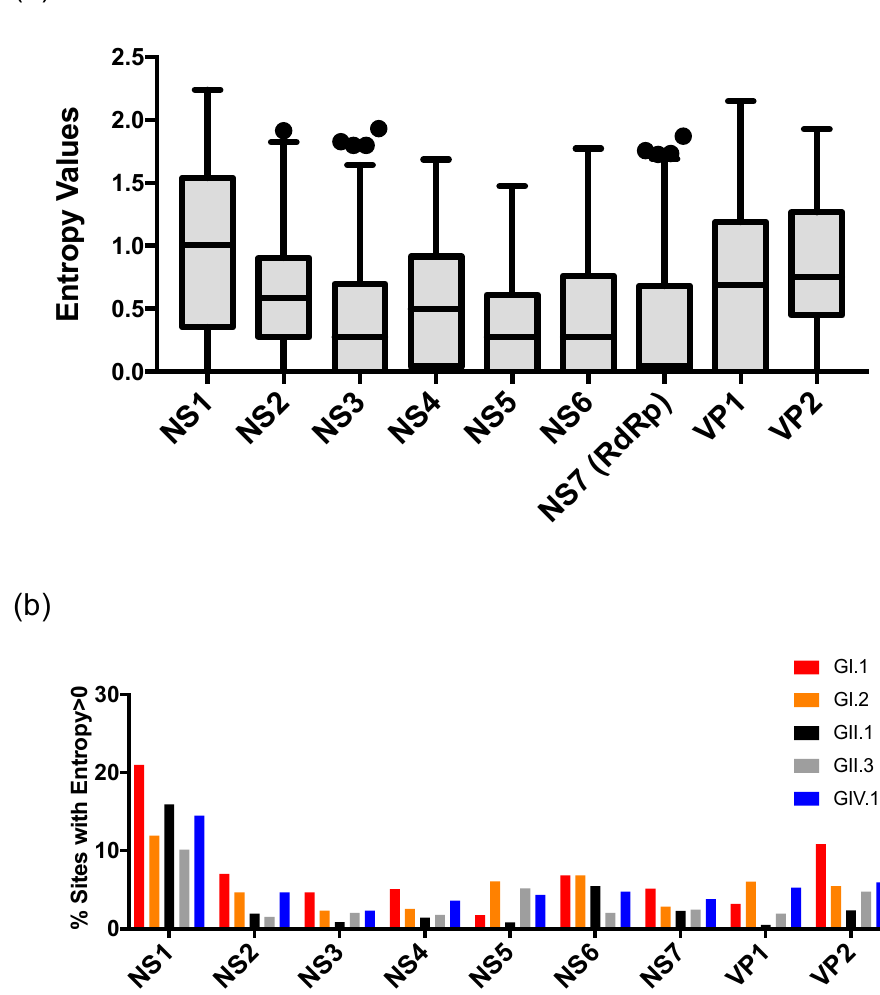
Figure 6. Genome conservation analyses of human sapovirus. ( a ) Shannon entropy values were calculated to quantify the amino acid variation for each site in the nonstructural and capsid proteins in ORF1 and 2 from human sapovirus GI, GII, GIV, and GV strains. Only the sequences with complete length available were included. Boxes represent 25th and 75th percentiles, and whiskers represent 1.5 × interquartile ranges from the box. Outliers outside the whiskers were shown by circles. ( b ) Shannon entropy values were calculated for major sapovirus genotypes, and summarized as a ratio (%) of sites with entropy > 0 (i.e., sites with ≥ 1 mutation(s)) at each of the proteins. Genomic regions were predicted based on the sapovirus strain GI.1/Manchester (X86560) [1].